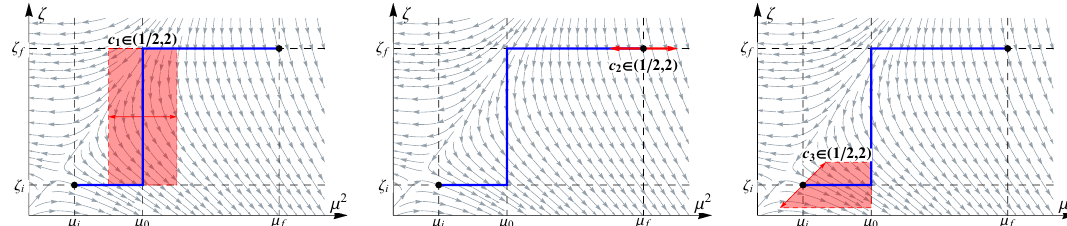
Figure 5 . Illustration of the path deformation during the variation of parameters c 1 (left), c 2 (center) and c 3 (right). The blue line shows the contour of the evolution in the generic improved D picture. Red arrows show the displacement of scale positions in the evolution plane during the variation. The red regions show the area which contributes to the solution-dependance (3.19). In the present choice of the evolution path, the variation of constant c 2 does not deform the solution. The variation of c 3 is given for (cid:16) i = (cid:22) 2 i